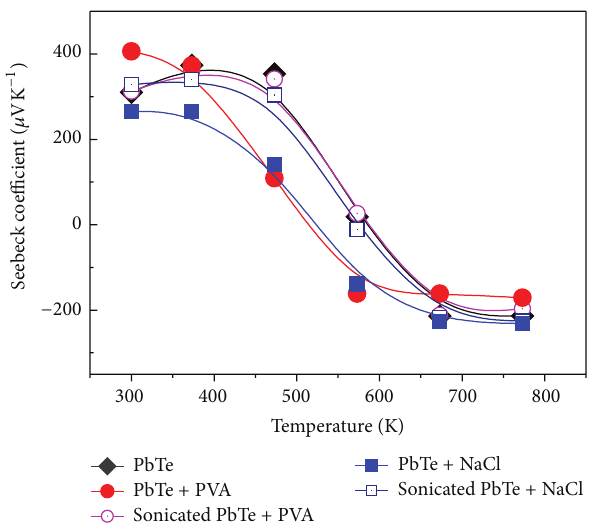
Figure 4: Seebeck coefficient values as a function of temperature for PbTe and PVA- and NaCl-embedded PbTe samples before and after sonication,